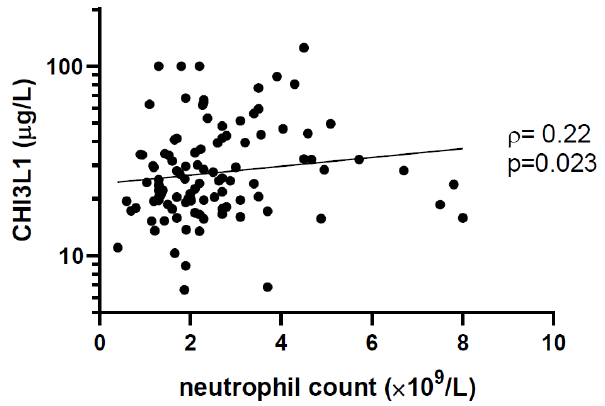
Figure 1. Plasma CHI3L1 level is correlated with neutrophil count. The concentration of CHI3L1 was measured by enzyme-linked immunosorbent assay (ELISA), and neutrophil counts were taken from patient clinical records. Non-parametric Spearman’s rank correlation coefficient ( ρ ) and the associated p -values are